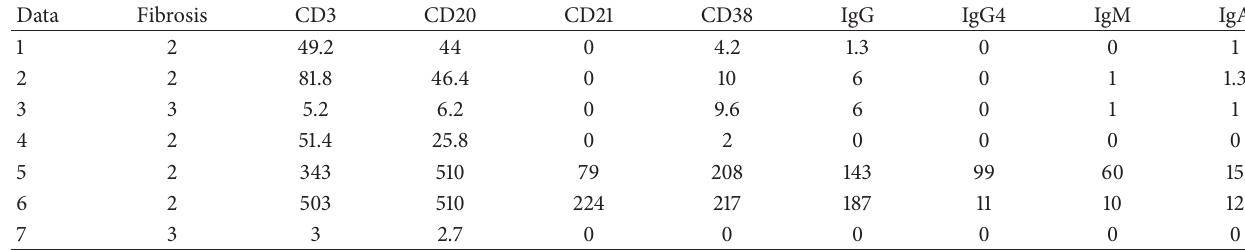
Table 2: Histochemical